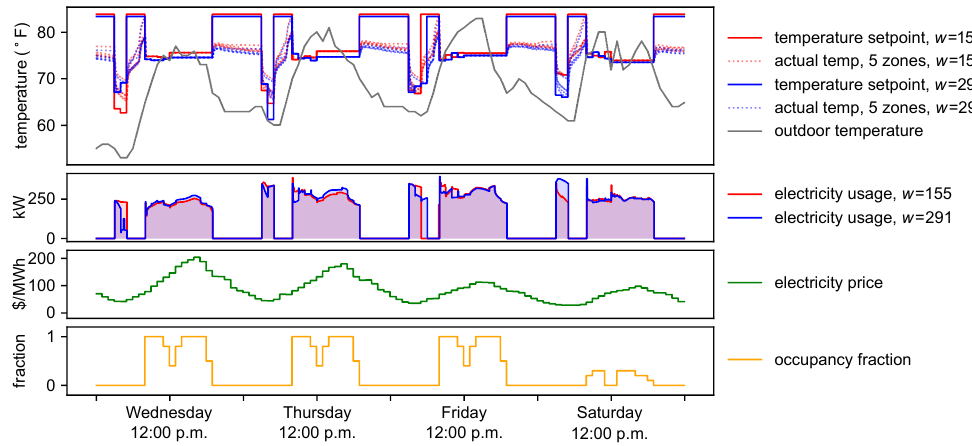
Figure 4. Hourly system operation with Cost-Comfort Particle Swarm Optimization (CCPSO) with two different penalty factors for four days beginning on 8 August